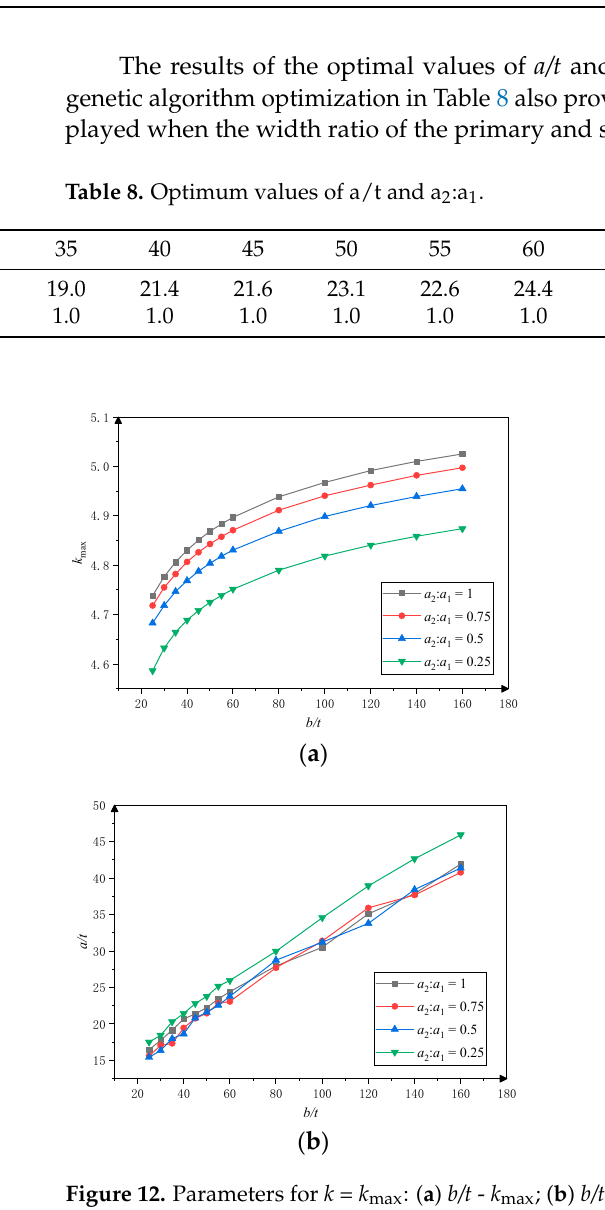
Table 7. Values of a/t when k = k max.